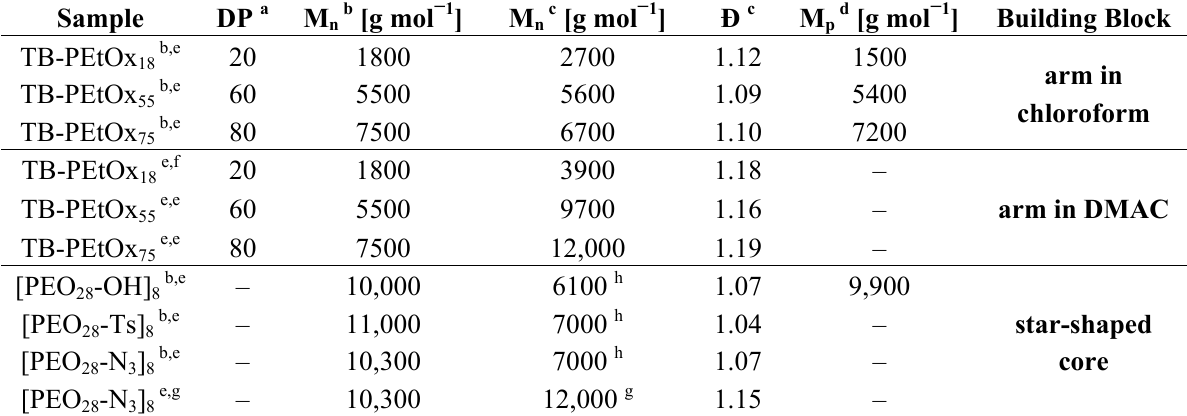
Table 1. Selected characterization data for alkyne-functionalized poly(2-ethyl-2-oxazoline)s ) and star-shaped [PEO (TB-PEtOx x